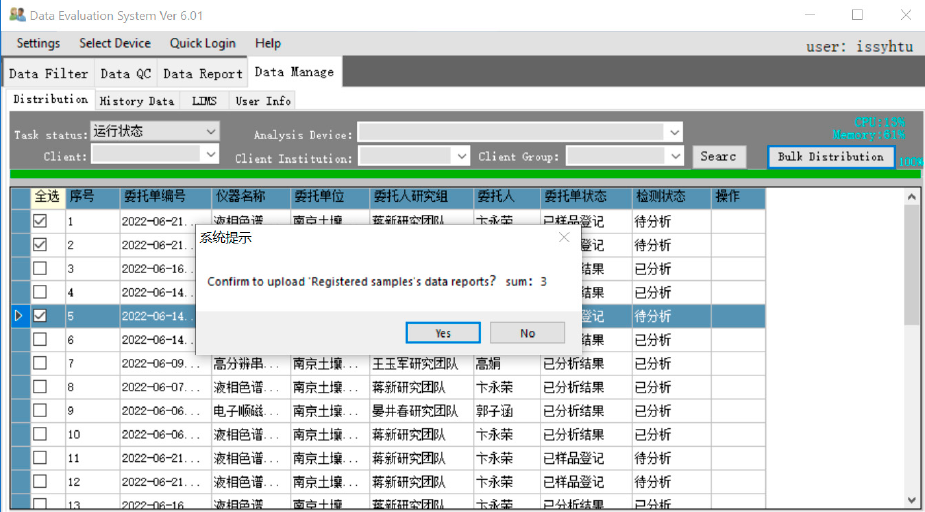
Figure 16. Data Manage and Distribute